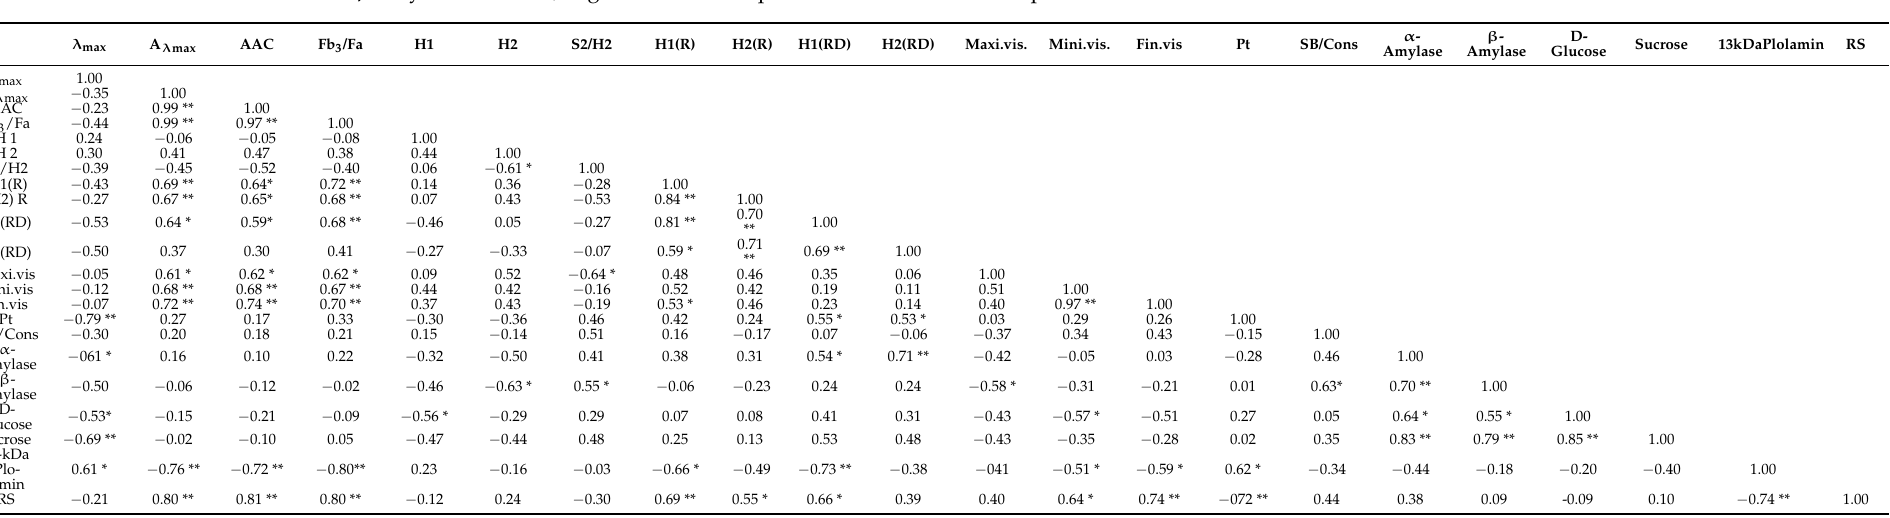
Table 6. Correlation between whole and chalky rice grains with the results of physical parameters of cooked rice, iodine analysis, pasting properties, RS content, α -and β -amylase activities, sugar contents and prolamin ratio of 7 rice